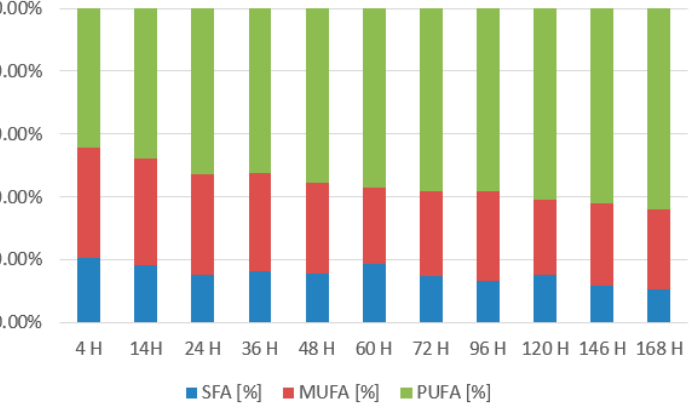
Figure 12. Biomass, lipid, and β -glucan production of Rhodotorula toruloides in a bioreactor cultivation on coffee oil and glycerol with lipase induction.